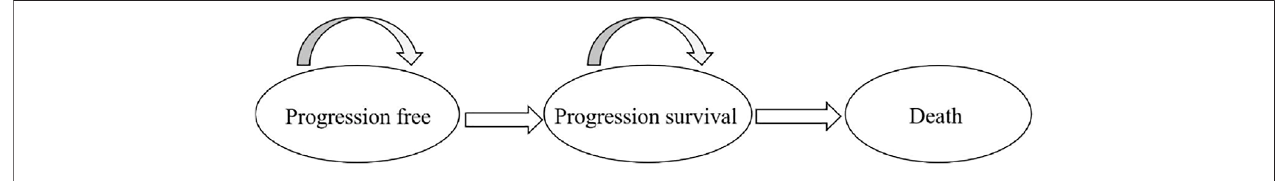
FIGURE 1 | The Markov state transition model. At the beginning of each Markov cycle, all patients entered the model in the progression-free survival (PFS) with a stable disease state and immediately commenced treatment. From this state, patients could either remain in a PFS state or experience progression and enter progression survival (PS). Patients in the PS could either remain in a PS state or transition to death. PS indicates the progression of the disease.